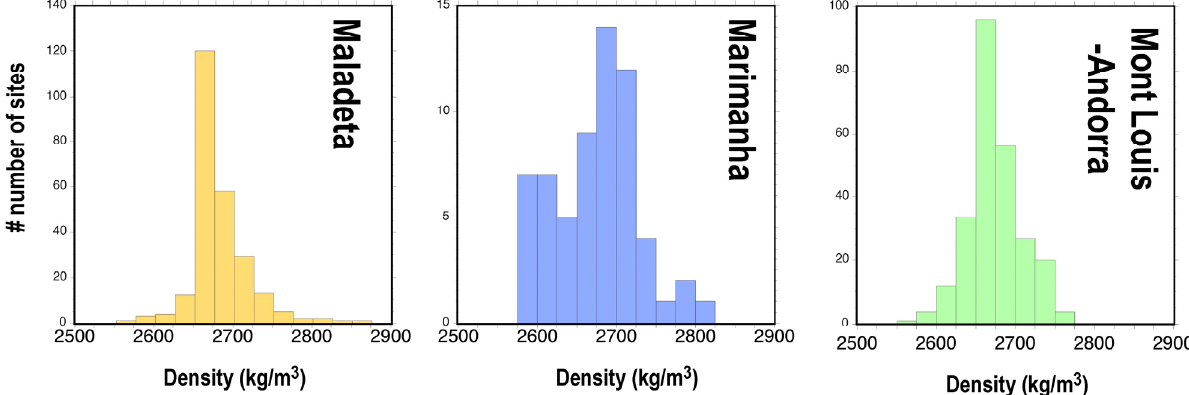
Figure 10. Density histograms for the three studied granitic massifs derived from the conversion of bulk susceptibility (from previous AMS studies) (counting interval 50 kg/m 3 ). Table 5. Density main statistical variables for the three studied bodies after the conversion of susceptibility data; Maladeta (MAL), Marimanha (MAR) and Mont-Louis Andorra (MAL). Density expressed as kg/m 3 .